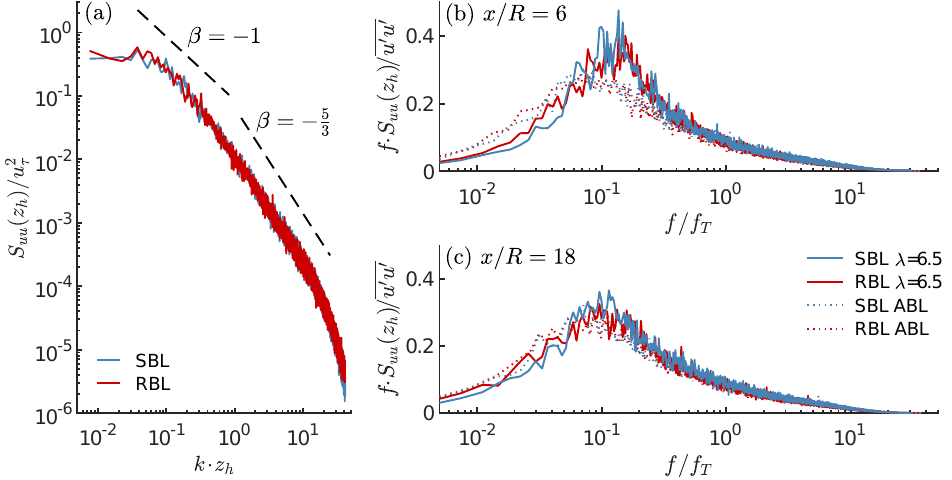
Figure 3. ( a ) Normalised energy spectral density of the axial velocity component S uu ( z h ) / u 2 τ within the boundary layers. Pre-multiplied normalised energy spectral density f · S uu ( z h ) / u (cid:48) u (cid:48) in the wake of the wind turbine at ( b ) x / R = 6 and ( c ) x / R = 18, all measured at hub height z h . The legend denotes flow conditions, dashed lines denote the slope of the Kolmogorov